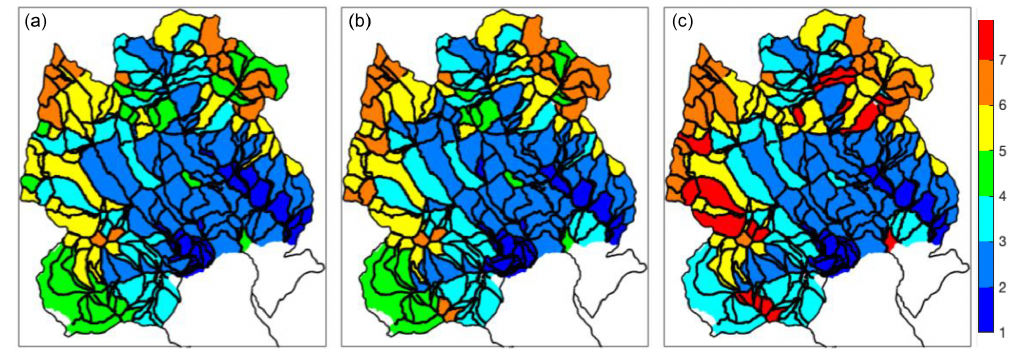
Figure 4. Hillslope zonation based on (a) Gaussian mixture model (GMM), (b) K-means (KM), and (c) hierarchical clustering (HC). Different zones are represented by the cluster index from 1 to 7. There are six common zones among the three methods, and one additional zone (Zone 7) appears in the HC result (c) . The black lines are the hillslope